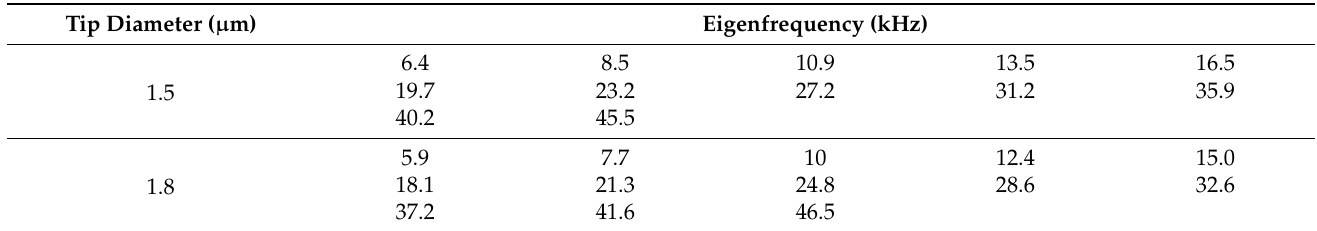
Table 1. Simulated eigenfrequencies of the tapered-tip fibers with different tip diameters. Tip Diameter ( µ